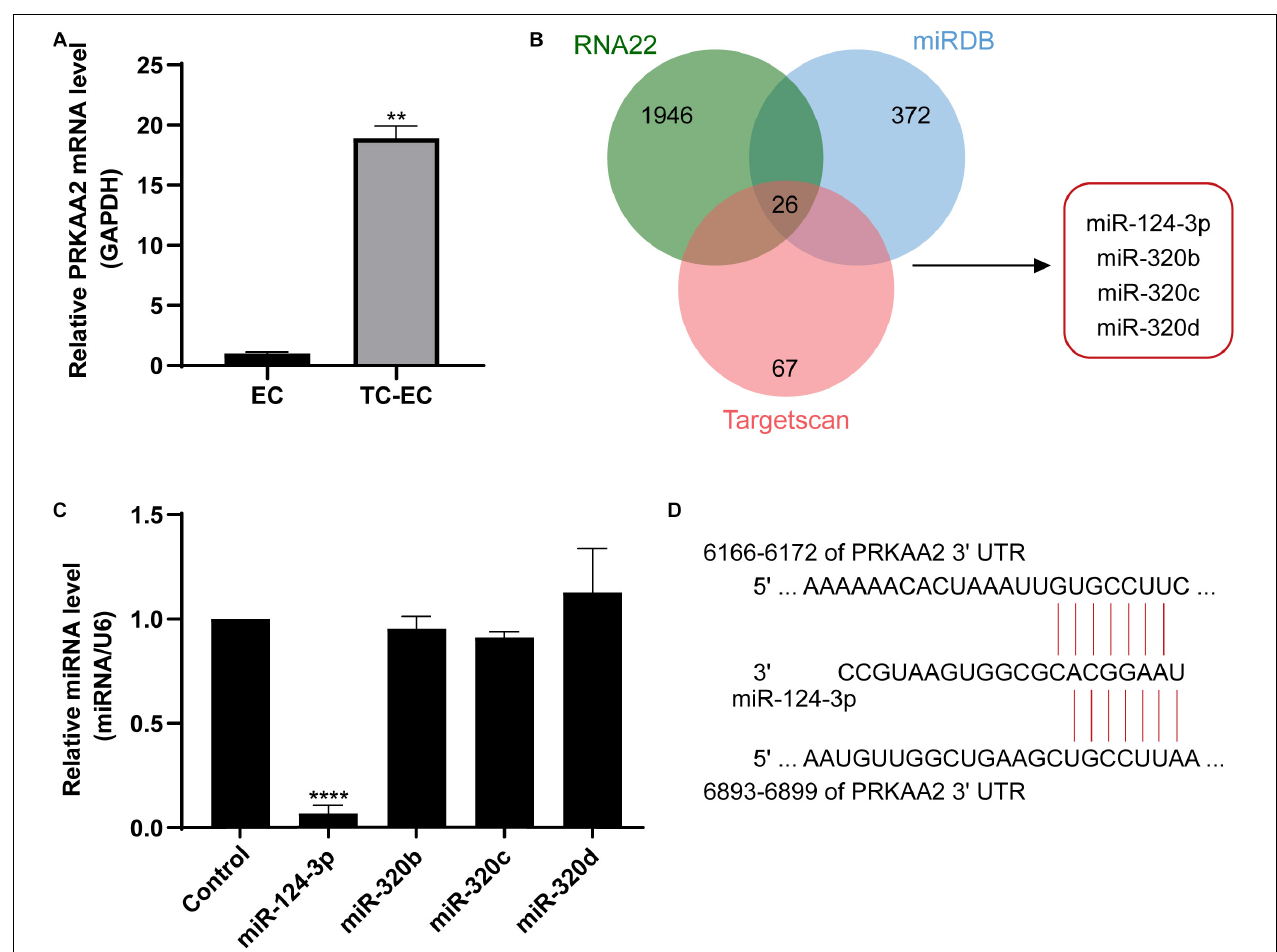
FIGURE 6 | (A) The relative expression of PRKAA2 was significantly upregulated in the TC-EC model, compared with EC alone. (B) The prediction of miRNAs targeted at PRKAA2, using miRDB, RNA22, and Targetscan database. (C) qPCR analysis of relative expression levels of 4 predicted miRNAs targeted at PRKAA2, in which the expression of miR-124-3p was significantly decreased in endothelial cells adhered by PC-3M. (D) Predicted binding sites within the 3’UTR region of PRKAA2 with miR-124-3p using the Targetscan database. The data are presented as the means ± SD . ( n = 3, ** P < 0.01, **** P < 0.0001, TC-EC vs.